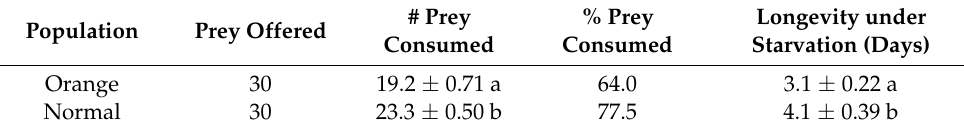
Means ± SE within each column followed by the same letter are not significantly different ( p > 0.05; Tukey